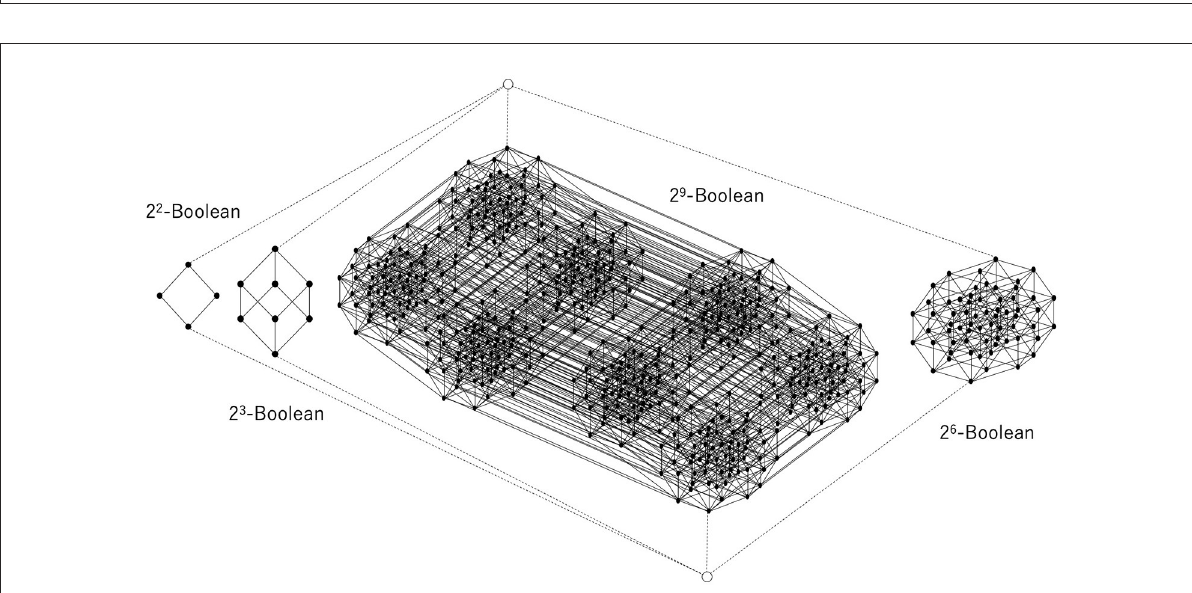
Figure 6 shows the whole construction of a lattice corresponding to a whole relation. Each black circle represents an element of a (sub)lattice that is a subset of D . The greatest element and the least element are represented by white circles,